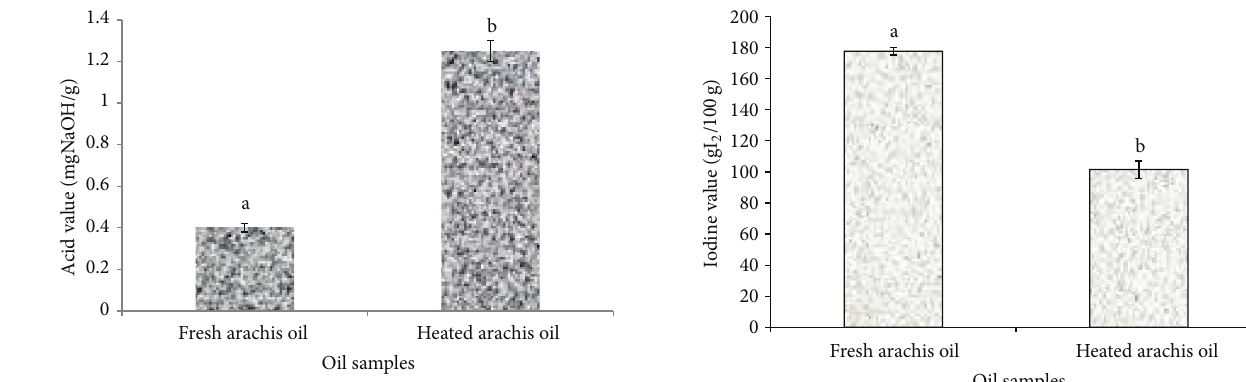
Figure 4: Effect of thermal oxidation on iodine value of arachis oil. Iodine values are expressed as mean ± standard deviation ( 𝑛 = 3 ). Bars with different alphabets are significantly different ( 𝑃 < 0.05 ).